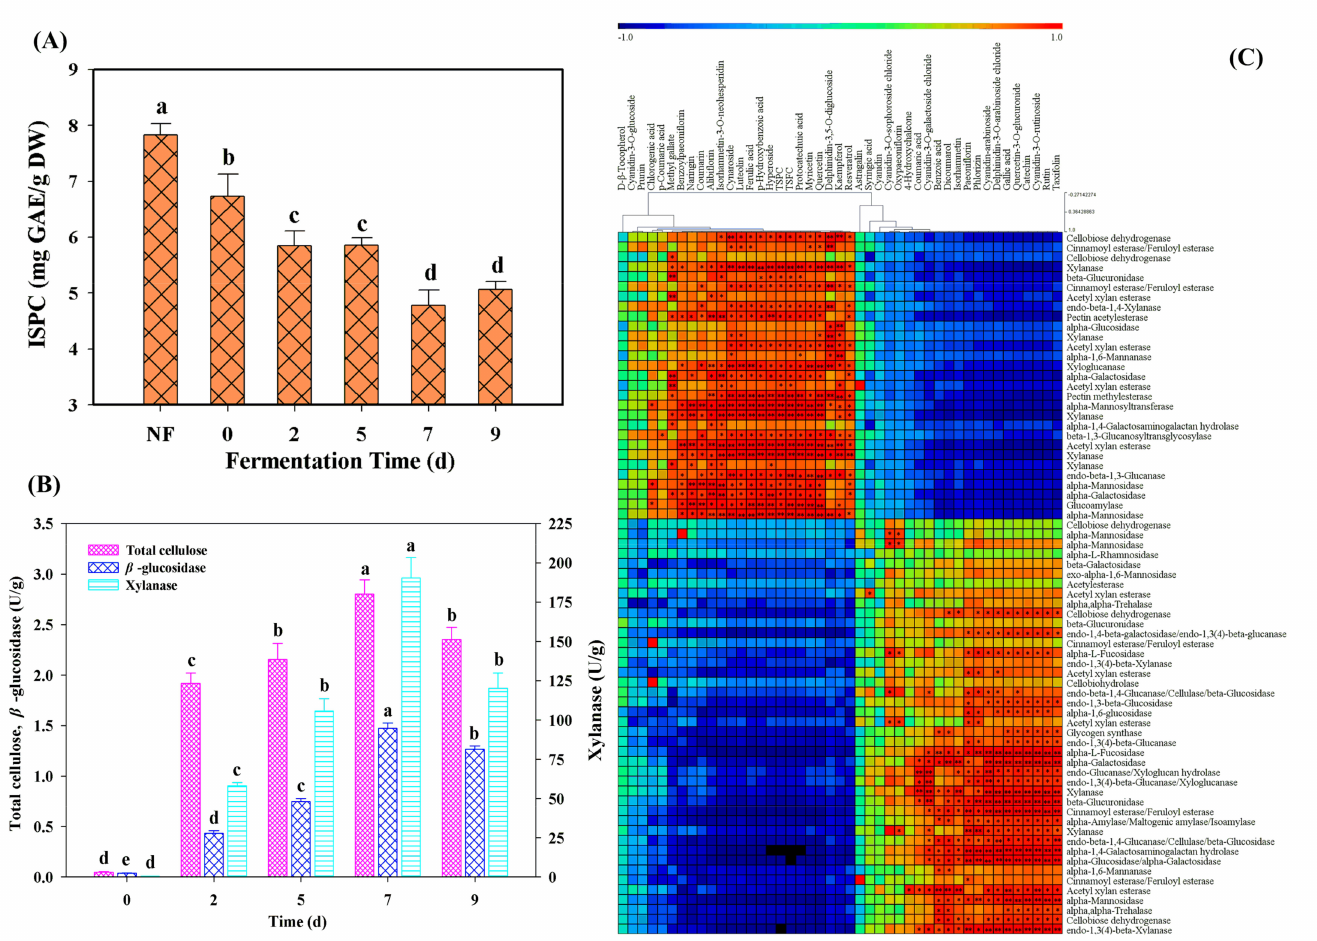
Figure 5. The contents of ISPC content ( A ), carbohydrate-hydrolyzing enzymes activities ( B ) and the correlation analysis among individual phenolic compounds, TSPC, TSFC and carbohydrate- hydrolyzing enzymes ( C ). NF stands for non-fermented Chinese jujube. ** and * represents the significant level at p < 0.01 and p < 0.05, respectively. Different superscripts (abcde) indicated significant differences between samples at the different fermented times ( p <